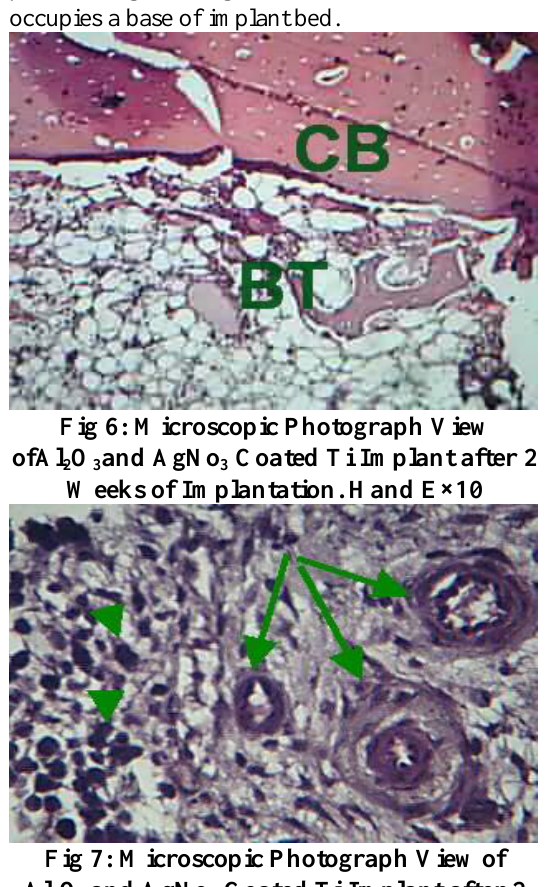
Fig 7: Microscopic Photograph View of Al O and AgNo Coated Ti Implant after 2 2 3 3 Weeks of Implantation. Hand E×40 After 4 weeks of implantation, in figure 8 the histological feature of Al O and AgNo coated 2 3 3 CpTi implants illustrated immature new bone (NB) with haversian canals (arrow), filled base of